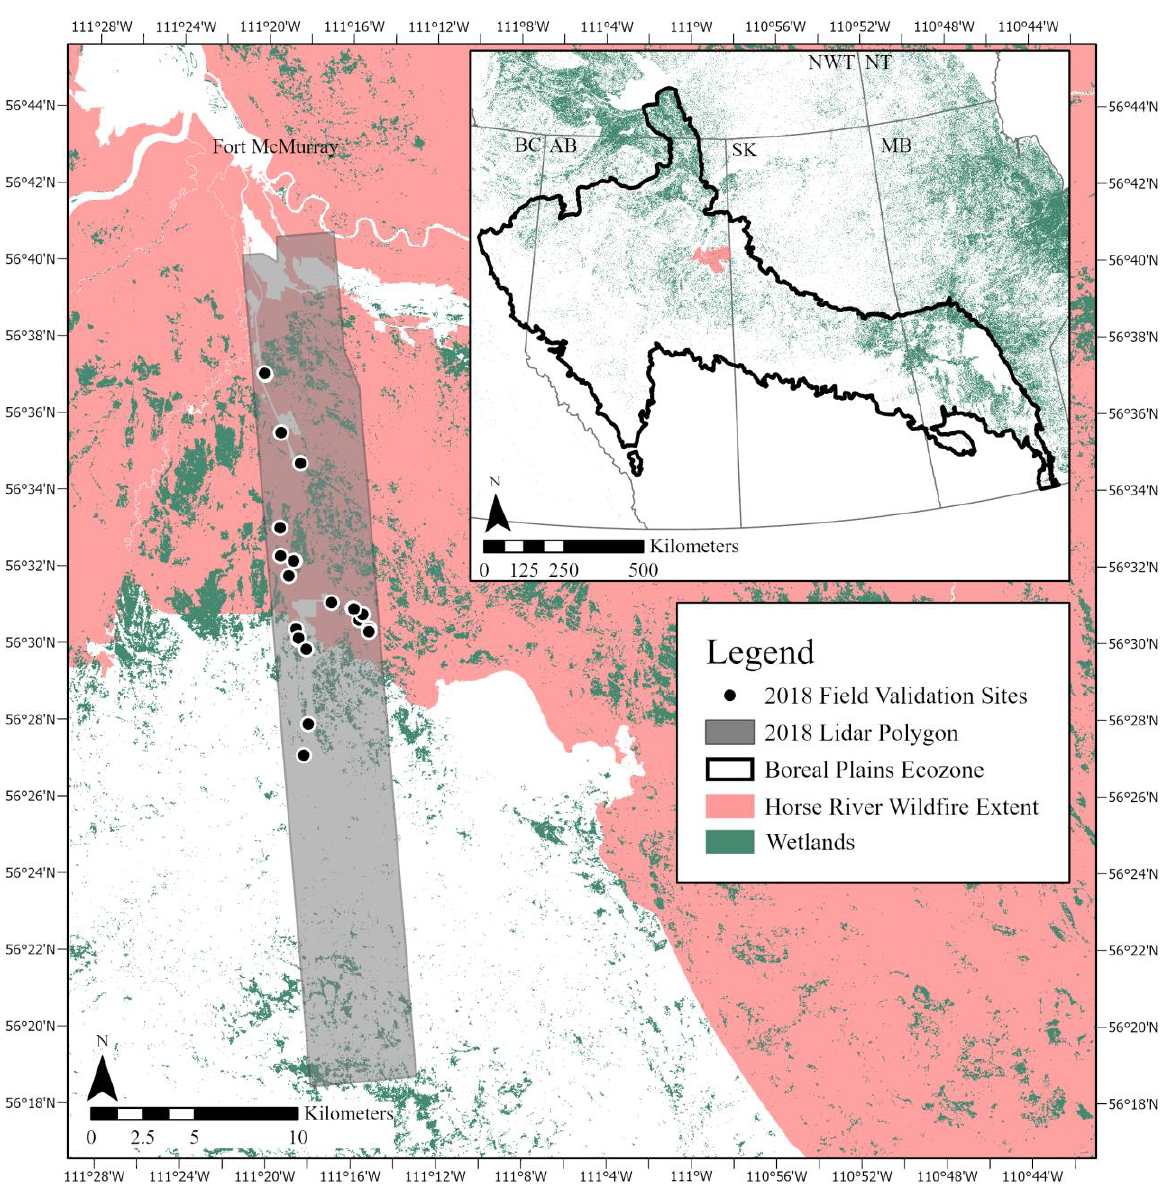
Figure 1. Map illustrating the extent of the Horse River Wildfire within the Boreal Plains Ecozone (inset), which extends across Canada from northern British Columbia (BC) and into Alberta (AB), Saskatchewan (SK), and Manitoba (MB) and the study area, including lidar survey polygon and field validation